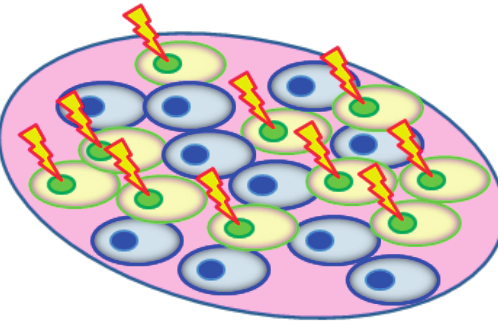
Figure 3. The cells (A549 or WI38) to be irradiated by microbeam protons were labeled with cell tracker orange (CTO) 1 day before irradiation, which were then mixed with unlabeled A549/WI38 cells in a 1:1